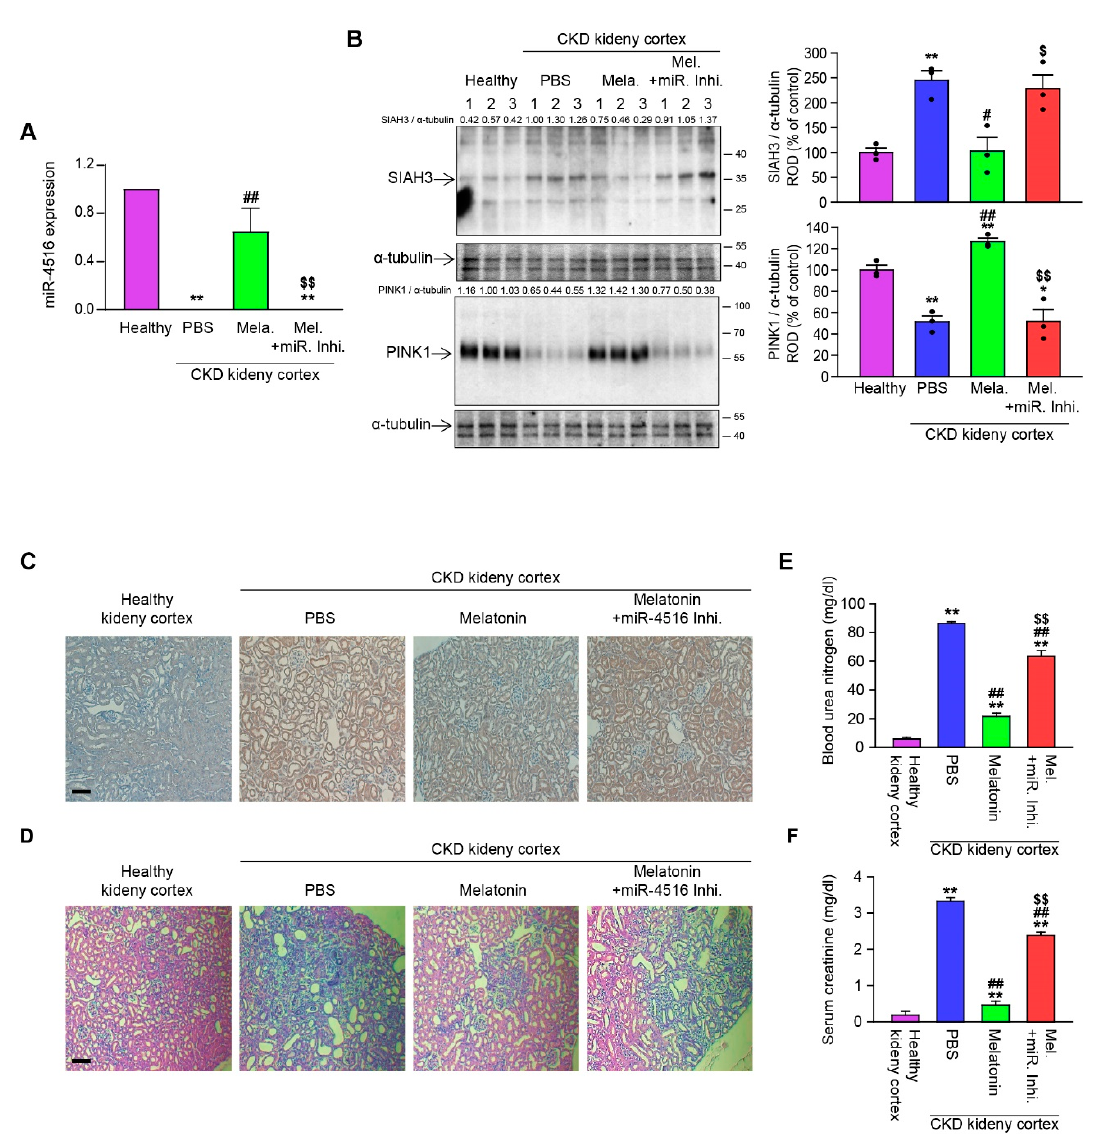
Figure 5. Melatonin injection ameliorates fibrotic CKD and improves kidney function in a CKD mouse model via miR- 4516/SIAH3/PINK1 pathway. ( A ) miR-4516 expression level in renal cortex of healthy kidney control and CKD mice either treated with melatonin, or both melatonin and miR-4516 inhibitor, measured by qRT-PCR ( n = 3). ( B ) Expression of SIAH3 and PINK1 in renal cortex of each groups. Protein expression level was quantified by densitometry and normalized to α -tubulin levels ( n = 3). ( C ) IHC staining for SIAH3 in renal cortex of each mouse group. ( D ) H&E staining of renal cortex of each mouse group. ( E , F ) Measurement of blood urea nitrogen ( E ) and creatinine ( F ) level in serum of each mouse group (n = 5). The values represent mean ± SEM, * p < 0.05, ** p < 0.01 versus healthy kidney control; # p < 0.05, ## p < 0.01 versus PBS; $ p < 0.05, $$ p < 0.01 versus melatonin. The α -tubulin was used as Western blot loading control for whole tissue lysates.